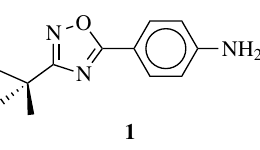
Figure 6. Chemical structure of 4-(3-( tert -butyl)-1,2,4-oxadiazol-5-yl)aniline 1